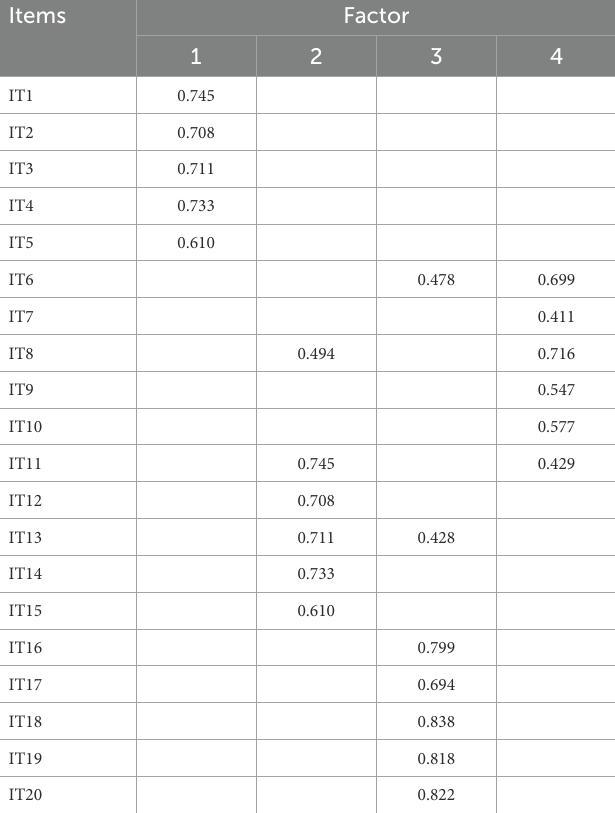
TABLE 1 Factor loadings after exploratory factor